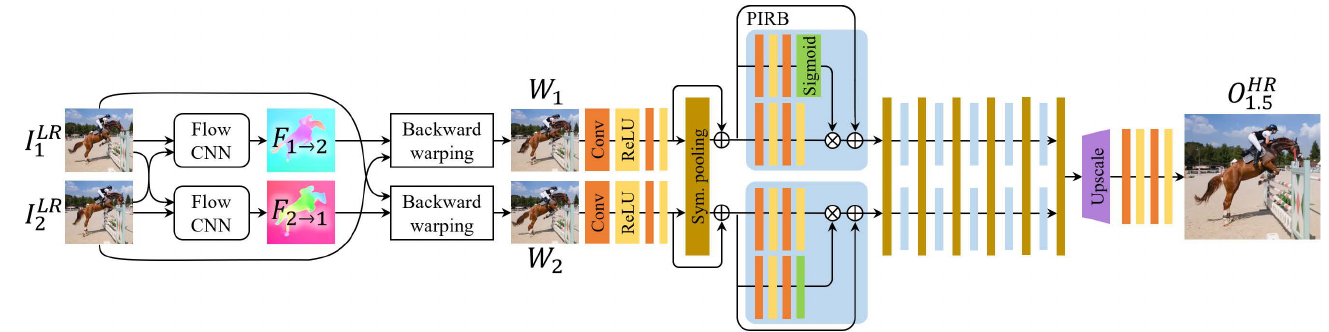
Figure 1. Illustration of the proposed architecture. For simplicity, we illustrate a case of two input frames but not limited. Given low-resolution image inputs I LR the input frames to the intermediate positions represented by W 1 , W 2 . These are fed through our permutation invariant module to extract complementary features. The features are upscaled and fed through a series of CNNs generating the high-resolution interpolated frame O HR